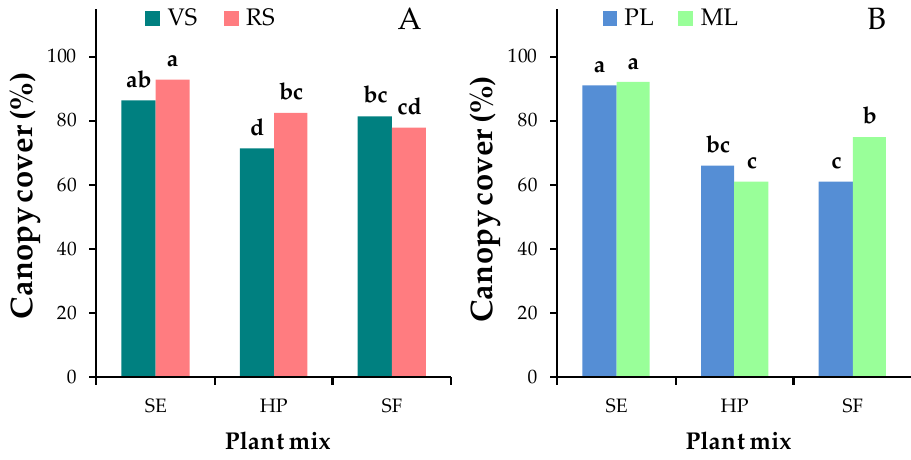
Figure 9. Interaction effects of plant mix × substrate ( A ) (November 2015) and plant mix × drainage/storage layer ( B ) (May 2016). Histogram values with different letters indicate significant differences according to Tukey’s HSD test ( p < 0.05). SE = Sedum mix, HP = herbaceous perennials, SF = suffruticose, VS = volcanic substrate, RS = recycled crushed brick substrate, PL = preformed plastic drainage/storage layer, ML = mineral drainage/storage layer.